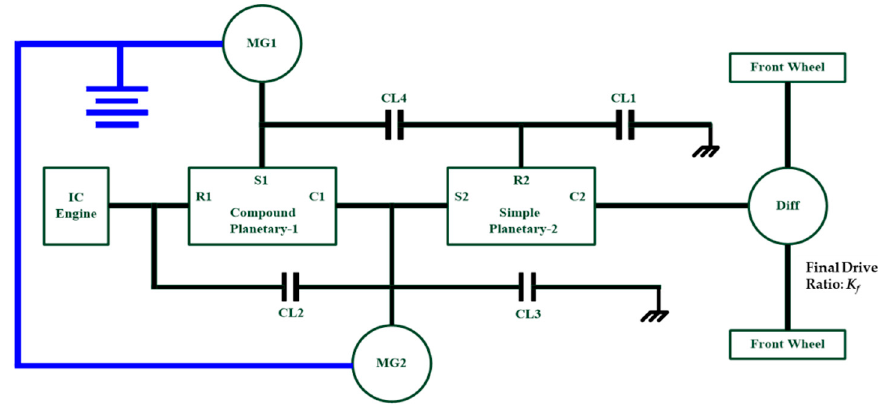
Figure 1. AHS-II two-mode powertrain architecture.